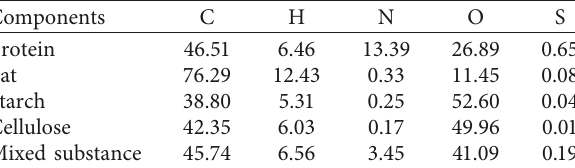
Table 2: Elements of the mixed substance